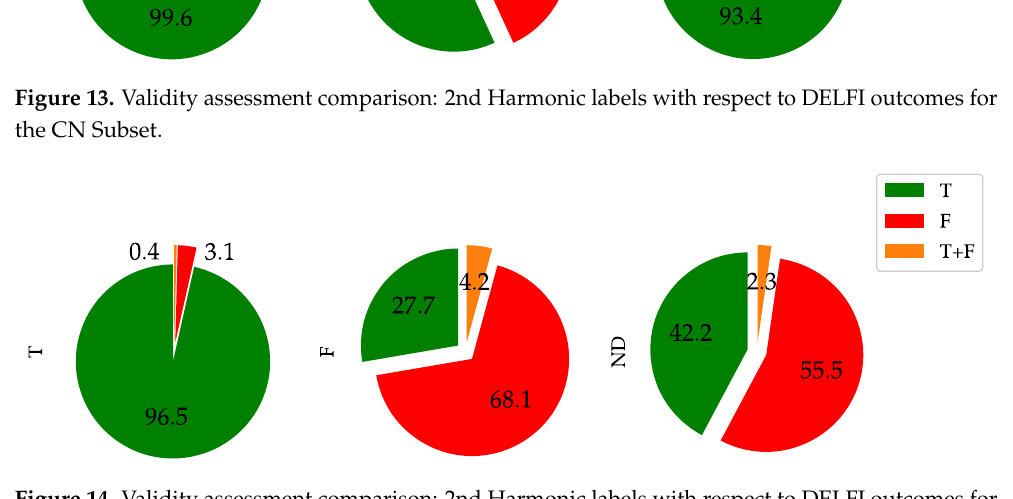
Figure 14. Validity assessment comparison: 2nd Harmonic labels with respect to DELFI outcomes for the IN Subset.